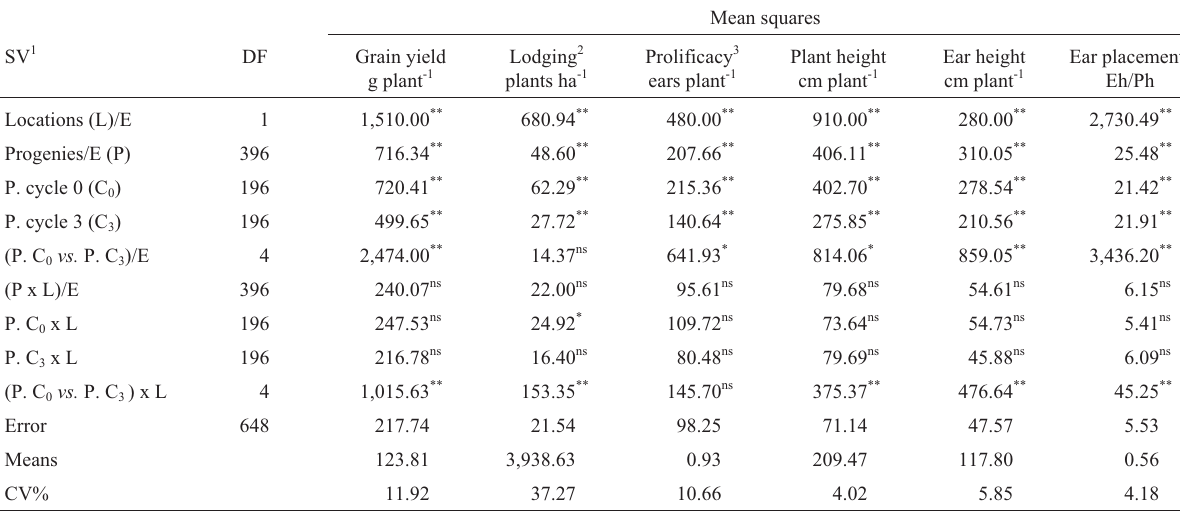
Table 1 - Values and significances of the mean squares from the joint analyses of variances for several traits. SV 1 DF Grain yield